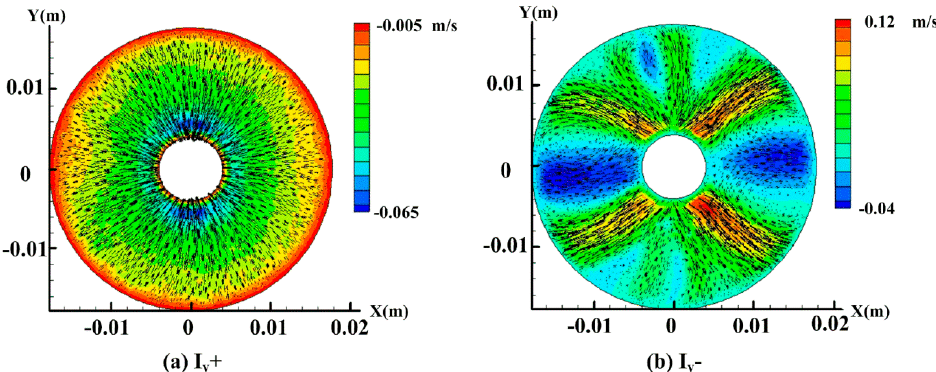
Figure 6. Contours of the radial velocity and the vector graph of velocity on the middle plane z = − 0.001 m with the imposed current I y = 3 A and I y = − 3 A in a different direction.